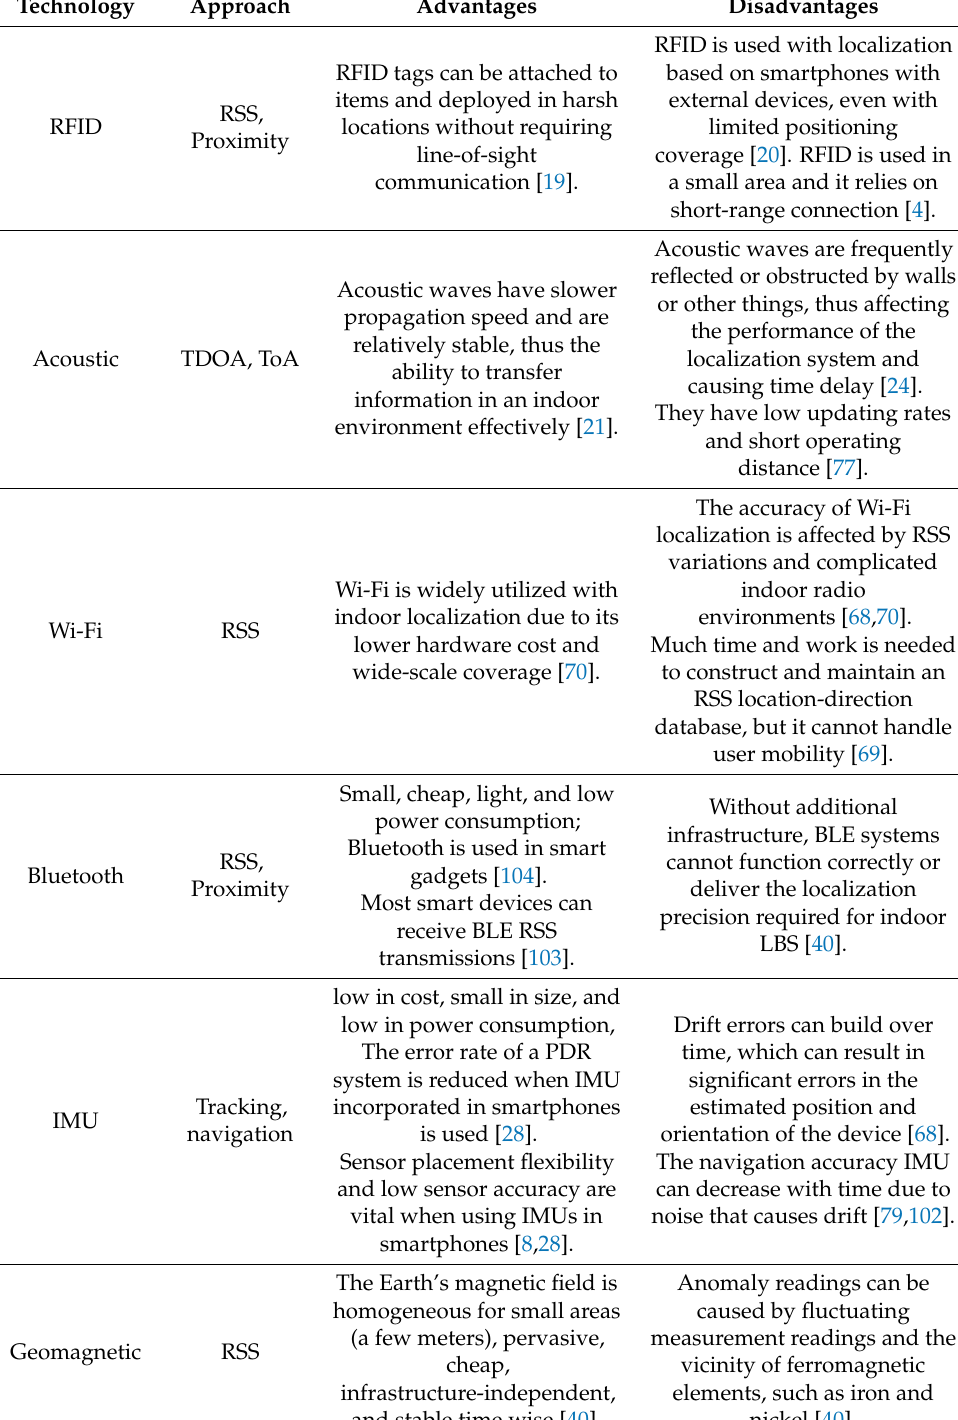
Table 2. Comparison of technologies used for indoor